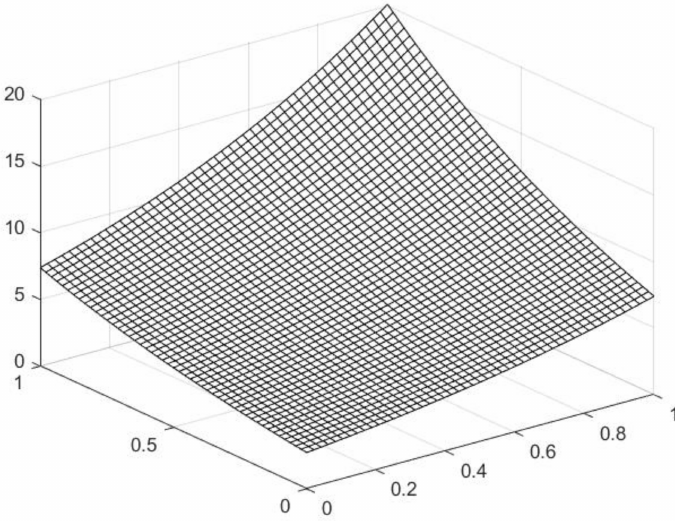
Figure 2. Numerical solutions of difference equations ( h = 1 / 64, τ = 1 / 2048 ) .